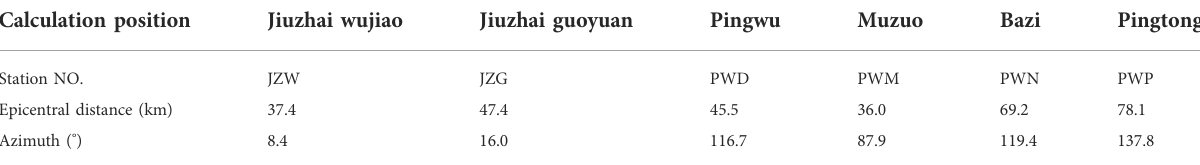
TABLE 4 Relative position of stations corresponding to calculation points.